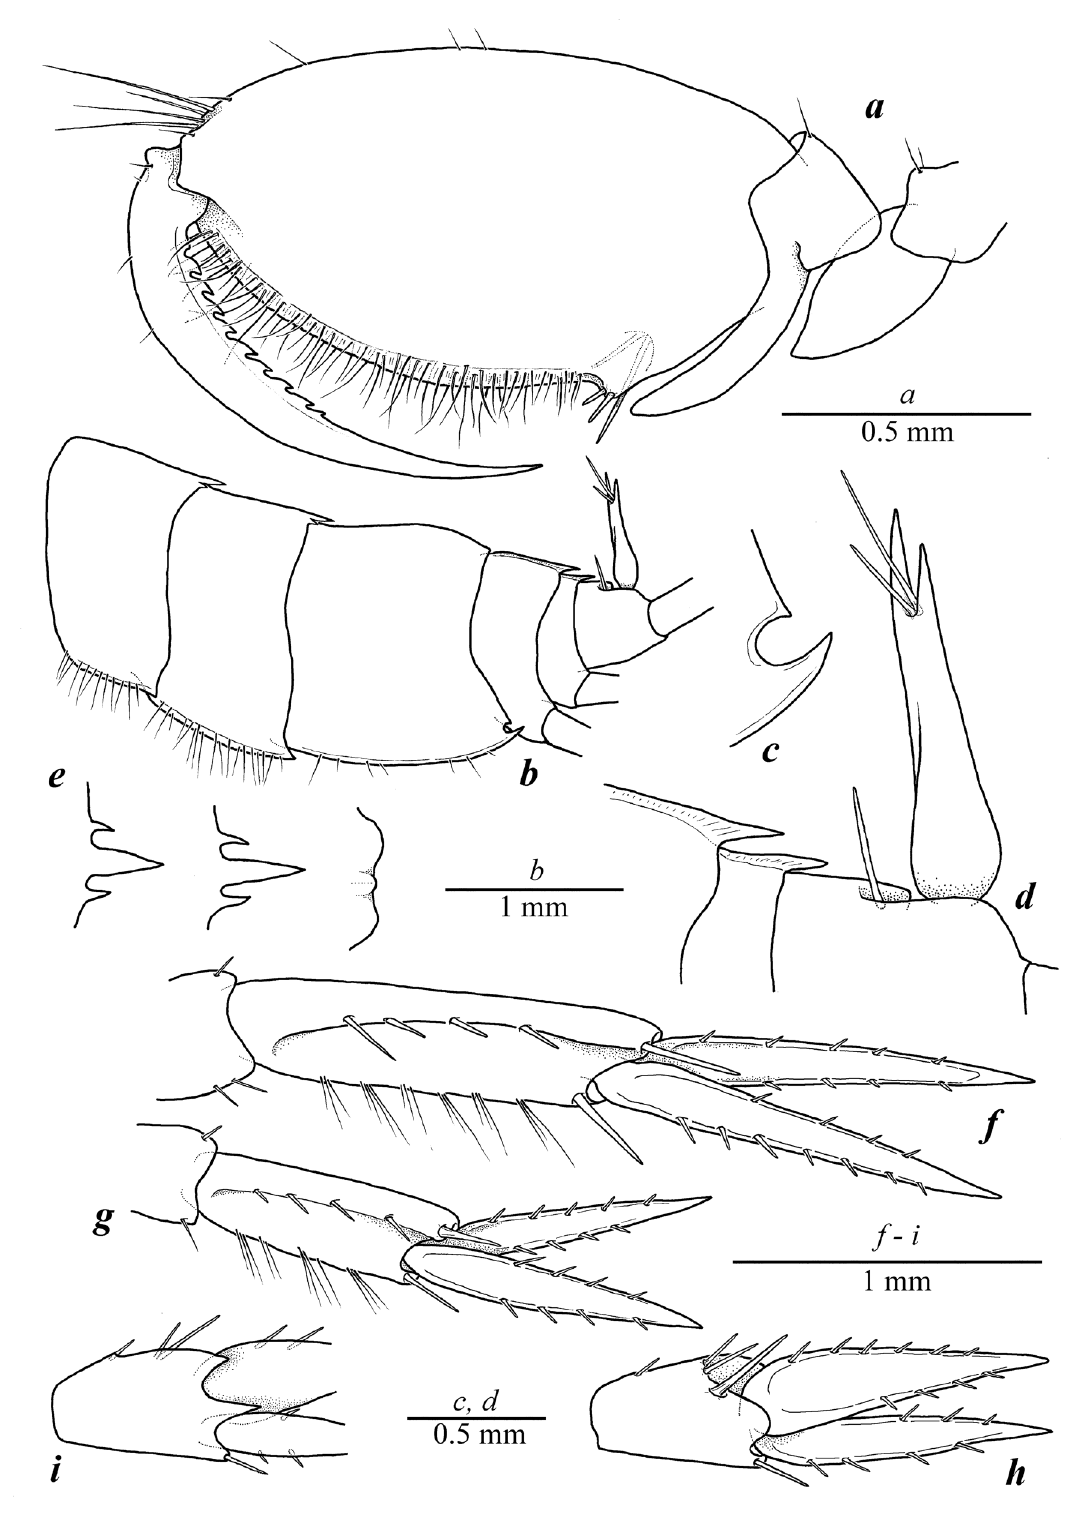
Fig. 5. Liljeborgia associata sp. nov., male (a) (LEMMI) and female (b–i) (LEMMI) from Vostok Bay of the Sea of Japan. a . Chela of Gn2 . b . Pleonites 1–3 and urosomites 1–3. c . Ventroproximal margin of pleonite 3. d . Urosomites 1–3 and telson. e . Dorsoproximal margins of pleonites 1–3. f . Uropod 1. g . Uropod 2. h . Uropod 3. i . Peduncle of uropod 1, outer